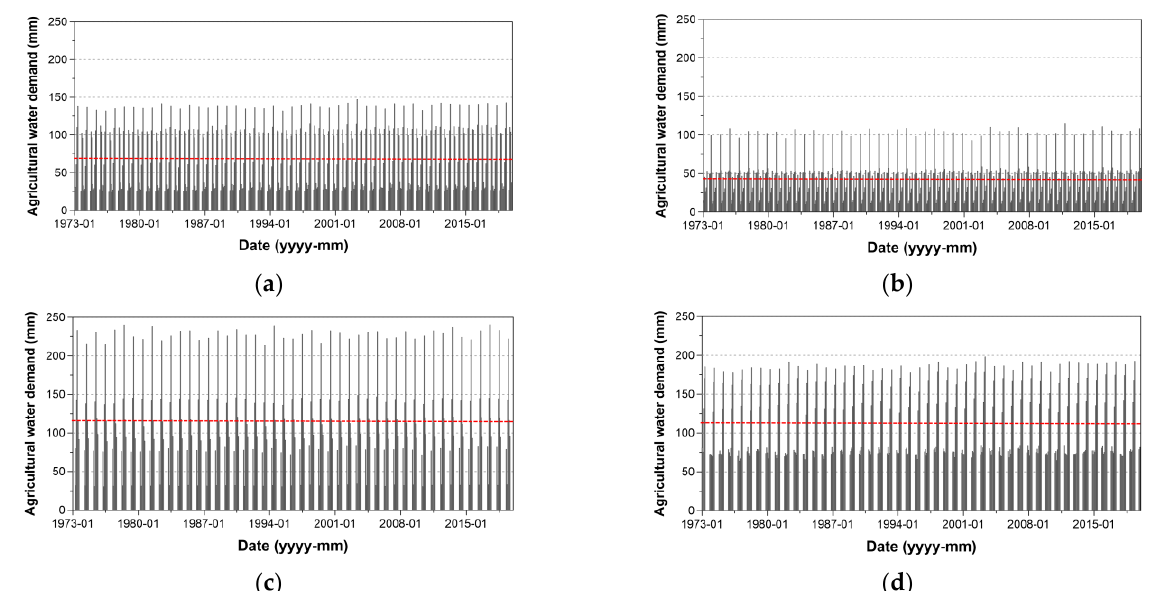
Figure 9. Agricultural water demand estimated for each crop considered in this study from 1973 to 2019. ( a ) Garlic; ( b ) Spring Onion; ( c ) Peanut; ( d ) Barley.